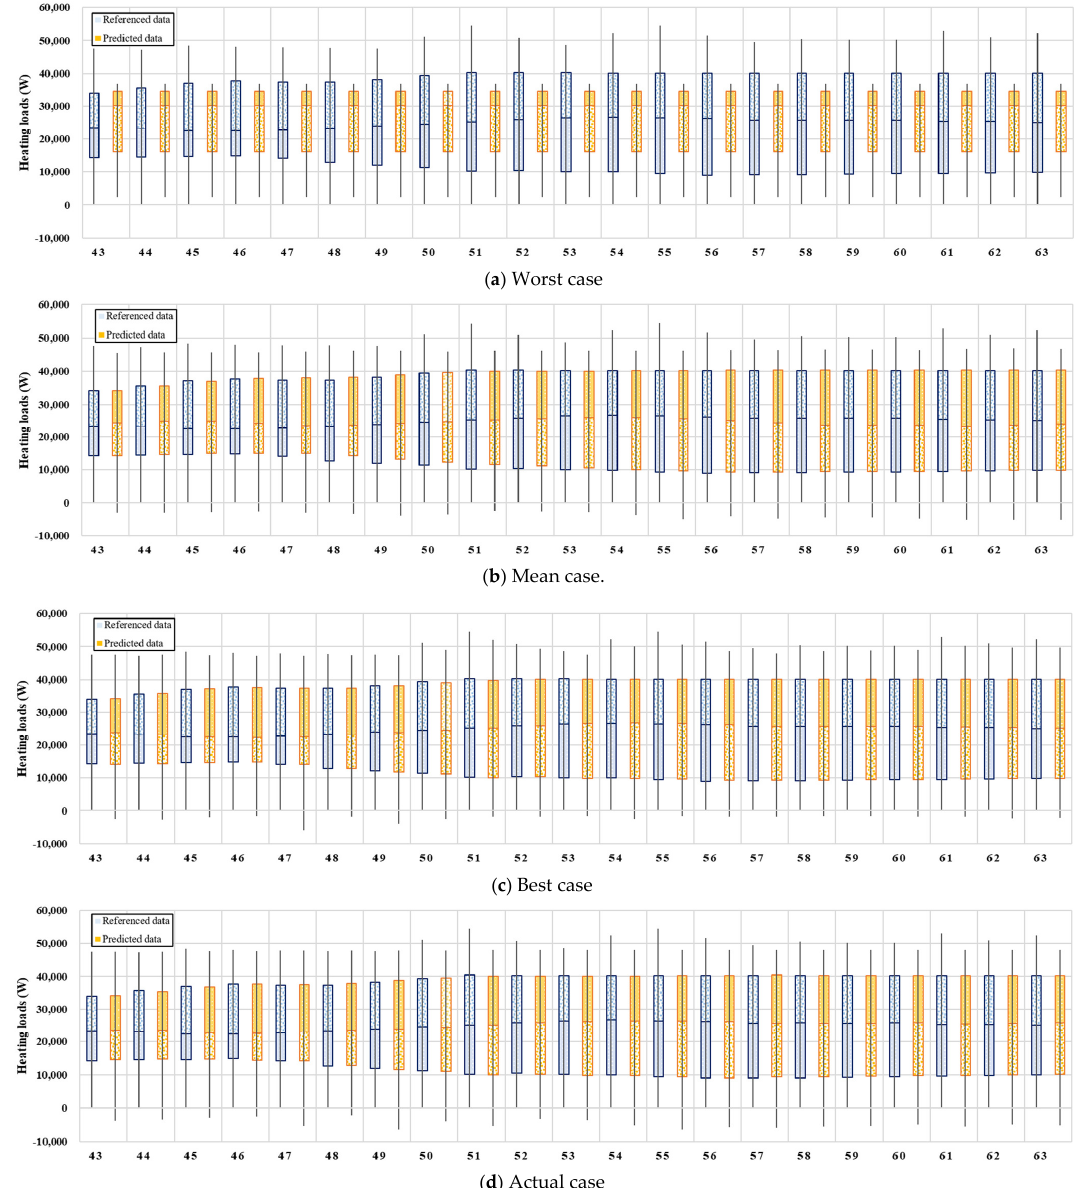
Figure 8. Distribution of the heating load for the supply water temperature.